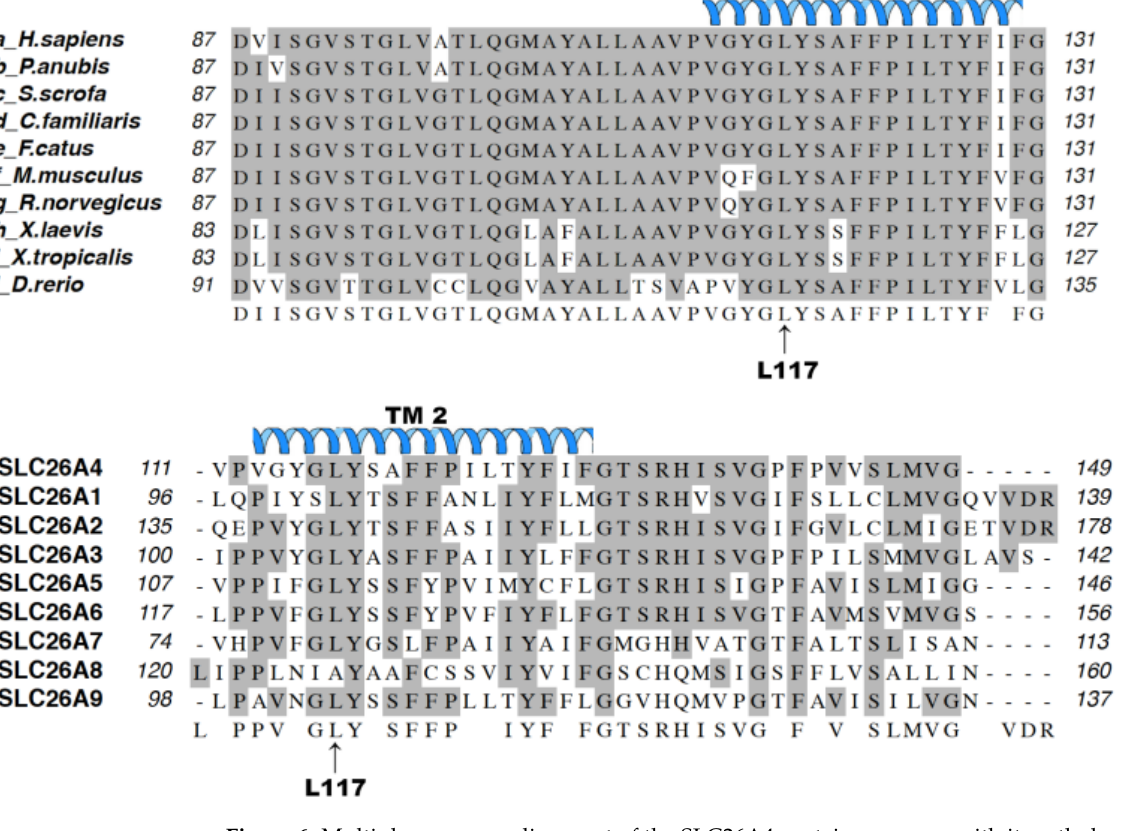
Figure 6. Multiple sequence alignment of the SLC26A4 protein sequence with its orthologues (top) and human paralogues (bottom). Amino acid residues conserved in all proteins are shaded in gray. The putative position of the second transmembrane (TM 2) α -helix according to [45] is indicated above the sequence. The position of the amino acid Leu117 (L117) is also given. (a) H. sapiens